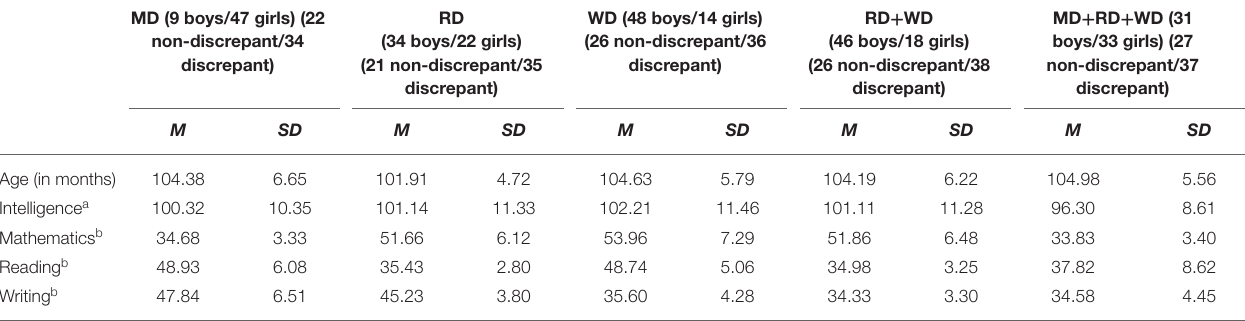
TABLE 1 | Means and standard deviations for age and classification measures as a function of